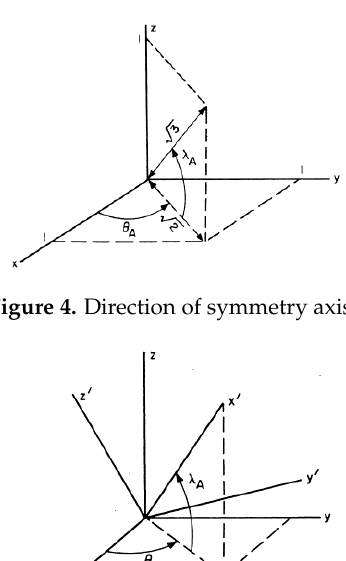
Figure 6. Direction angle of reflected beam.